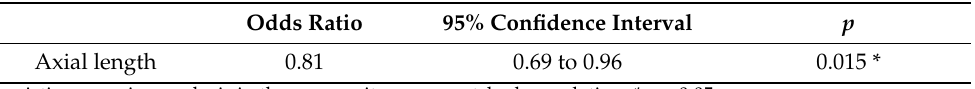
Table 4. Risk for exhibiting proliferative presurgical grade C at baseline in the propensity-score matched population.